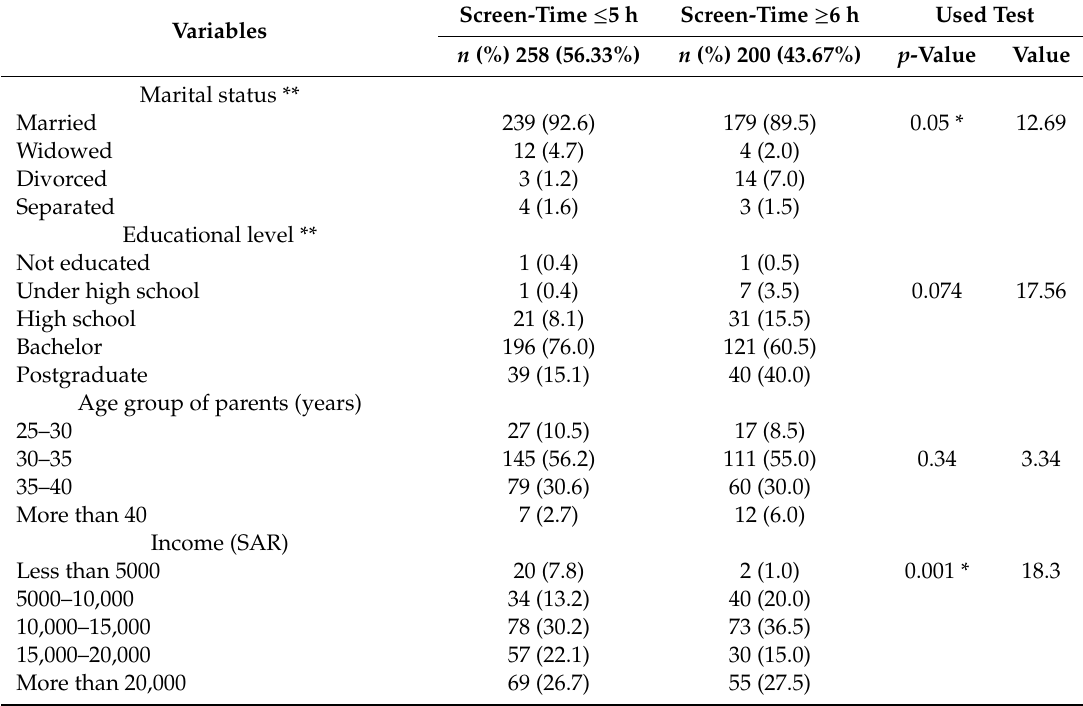
Table 1. Association between technology use and demographic